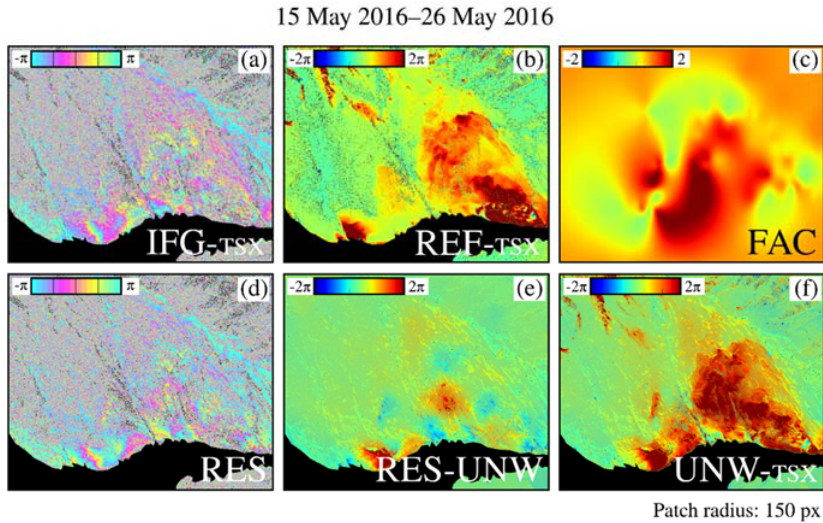
Table 6. Synthetic aperture radar (SAR) datasets used to test the warp demodulation method. Figure 8. Warp demodulation result for a representative TerraSAR ‐ X Staring Spotlight interferogram Figure 8. Warp demodulation result for a representative TerraSAR-X Staring Spotlight interferogram (X ‐ Band, 0.6 m ground range resolution, 11 ‐ day repeat cycle) covering 1 cycle. ( a ) IFG ‐ TSX, to ‐ be ‐ (X-Band, 0.6 m ground range resolution, 11-day repeat cycle) covering 1 cycle. ( a ) IFG-TSX, Sensor demodulated interferogram (wrapped); ( b ) REF ‐ TSX, reference interferogram (unwrapped); ( c ) FAC, to-be-demodulated interferogram (wrapped); ( b ) REF-TSX, reference interferogram (unwrapped); demodulation factor; ( d ) RES: demodulation residual (wrapped); ( e ) RES ‐ UNW: demodulation ( c ) FAC, demodulation factor; ( d ) RES: demodulation residual (wrapped); ( e ) RES-UNW: demodulation residual (unwrapped); and ( f ) UNW ‐ TSX, demodulated interferogram. The unwrapped phase in residual (unwrapped); and ( f ) UNW-TSX, demodulated interferogram. The unwrapped phase in ( b , e , f ) ( b , e , f ) is clipped to (cid:3399)2π . The demodulation patch radius is 150 pixels. is clipped to ± 2 π . The demodulation patch radius is 150 pixels.